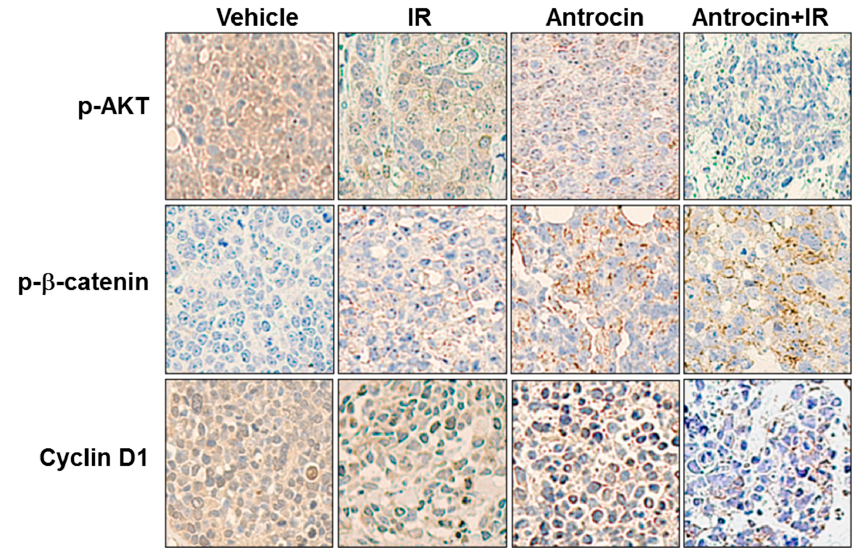
Figure 7. Representative immunohistochemical (IHC) staining patterns in xenograft PCa tissue. IHC analysis of paraffin sections show staining with specific antibodies against PARP, cleaved-caspase 9, phospho-AKT, phospho- β -catenin, and cyclin D1, respectively. Images were photographed at 200× magnification.